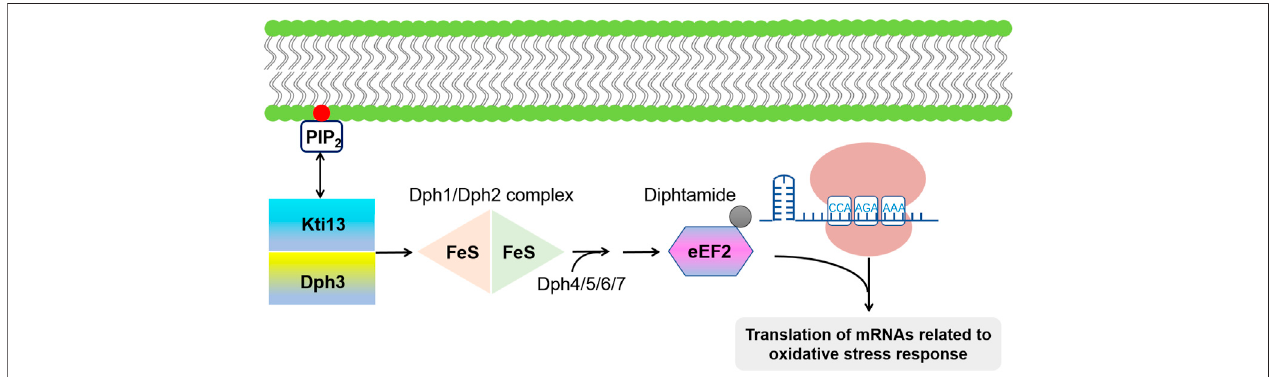
FIGURE 4 | Schematic of the diphtamide modi fi cation of eEF2. The fi rst step in this modi fi cation pathway is catalyzed by [4Fe-4S] cluster-containing protein complexDph1/Dph2;withthehelpofDph4/5/6/7.Dph3/Kti13heterodimeractaselectrondonorforDph1/Dph2complex.Ithasbeenreportedthatdiphtamidegroupof EF2 can further be ADP-ribosylated by the bacterial diphtheria toxin, leading to a global inhibition of protein synthesis as well as an upregulated translation of mRNAs associated with oxidative stress